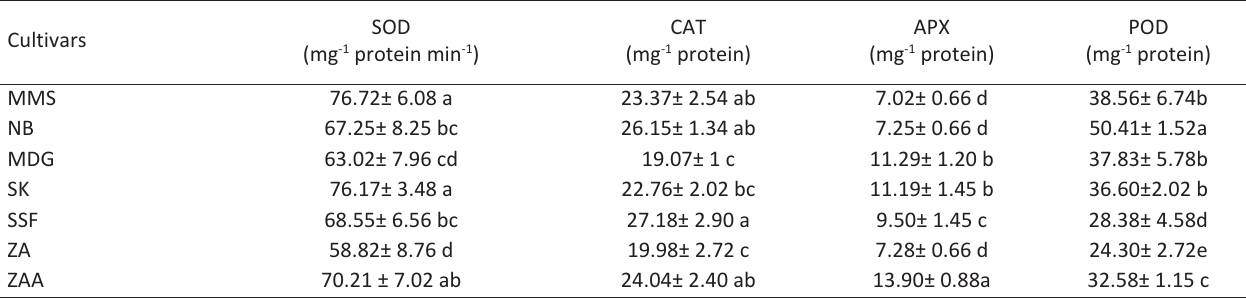
Table 2 ­ SOD, CAT, APX and POD activity in the leaves of different pomegranate cultivars Cultivars